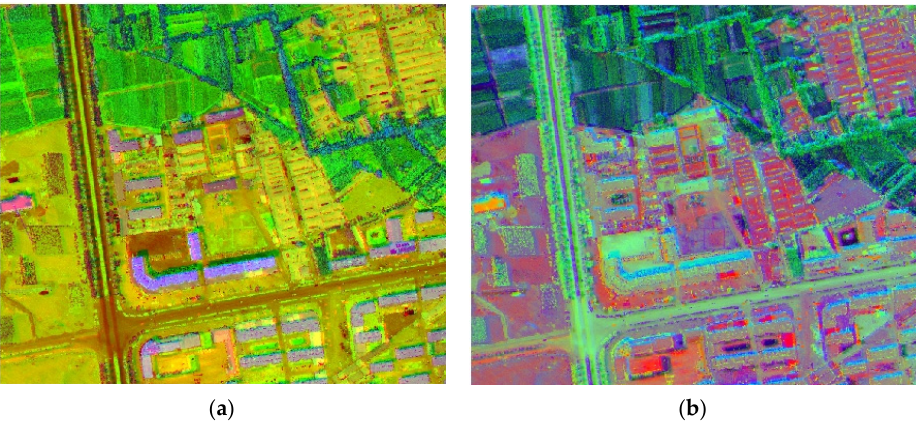
Figure 4. LiDAR-CASI fusion images with 1 m spatial resolution: ( a ) LiDAR-CASI stacked image (near infrared image of CASI, intensity image and nDSM); and ( b ) principal component analysis (first three principal